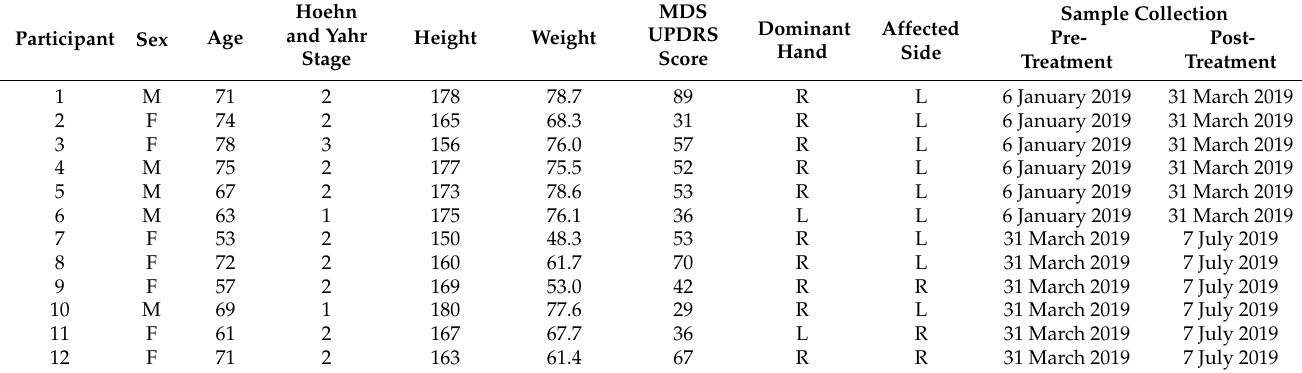
Table 1. Demographic data of participants in the PBM